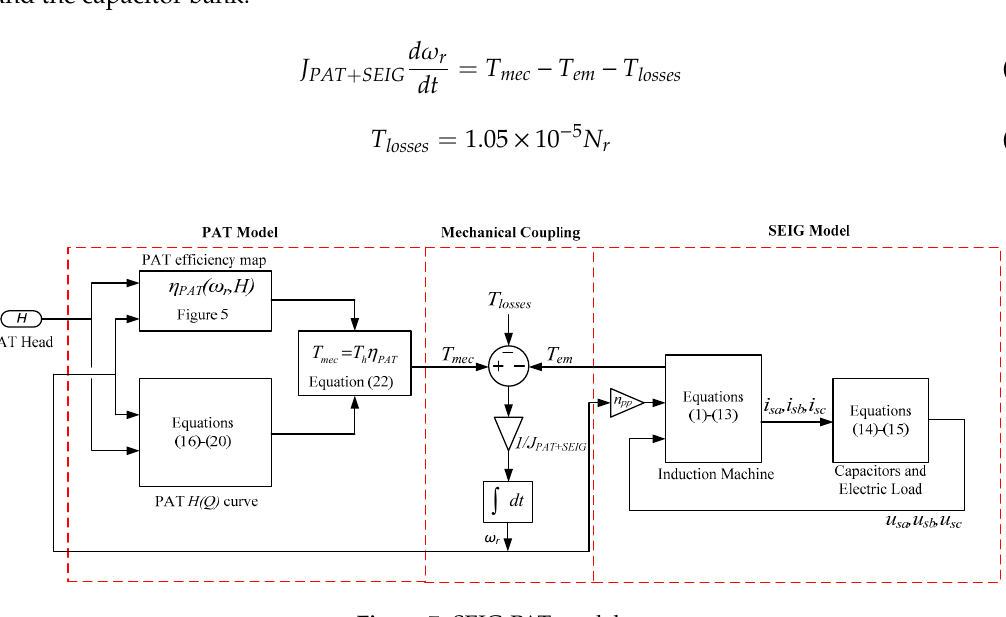
Figure 7. SEIG-PAT model.